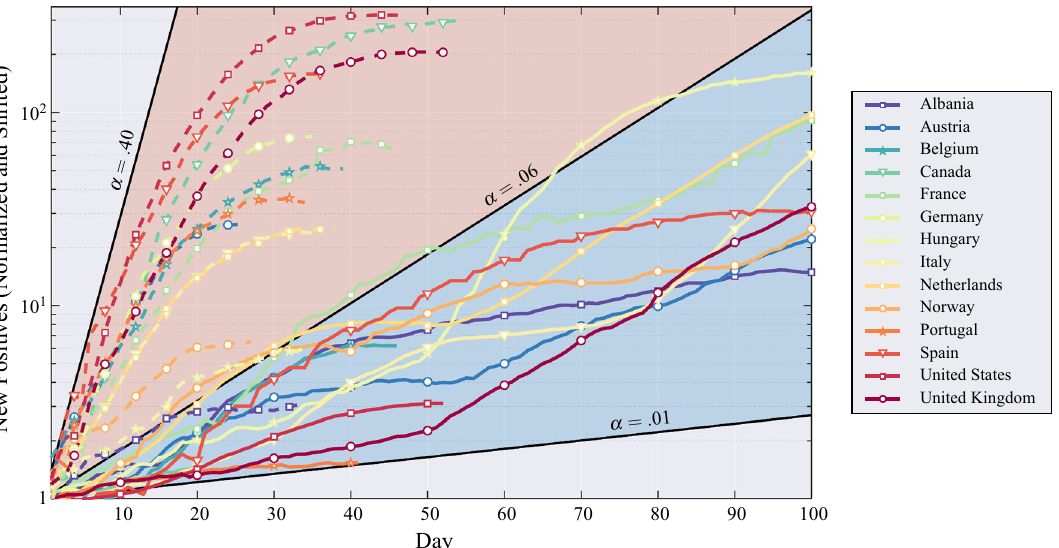
Figure 1. Number of COVID-19 daily new positives in the first and the second wave of the pandemic for several nations. Each curve is normalized by the initial value and shifted to the same initial time. The initial point of the first wave for a specific nation is when the first positives are reported, while the initial point of the second wave is when the daily positives start to increase again—growth rate larger than one. The first wave, upper region (shaded in red), was more aggressive than the second wave, mostly confined to the lower region (shaded in blue). These two regions are delimited by different values of α in Eq. (1). Curves of each nation are dashed if related to the first wave otherwise solid if related to the second